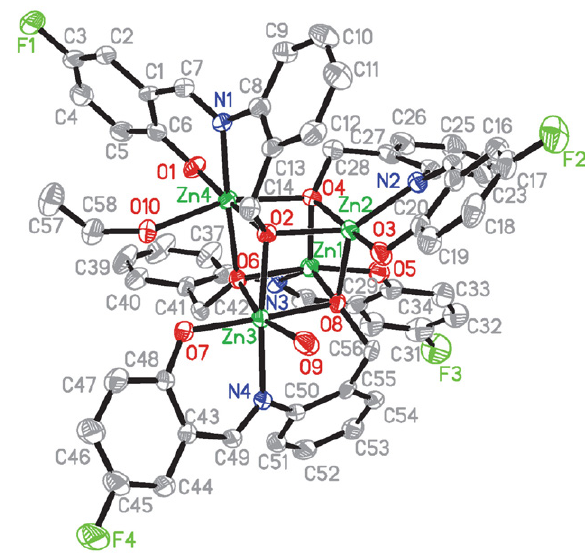
Fig. 3. ORTEP diagram of complex 2 with 30% thermal ellipsoids for all non-hydrogen atoms. Hydrogen atoms are omitted for clarity.